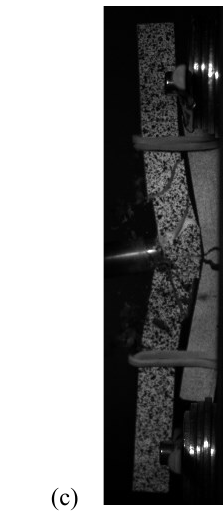
Fig. 8. Failure modes for a) Unbacked ceramic b) polymer backed - Bonded c) polymer backed - Unbonded (polymer backing fixed by an elastic